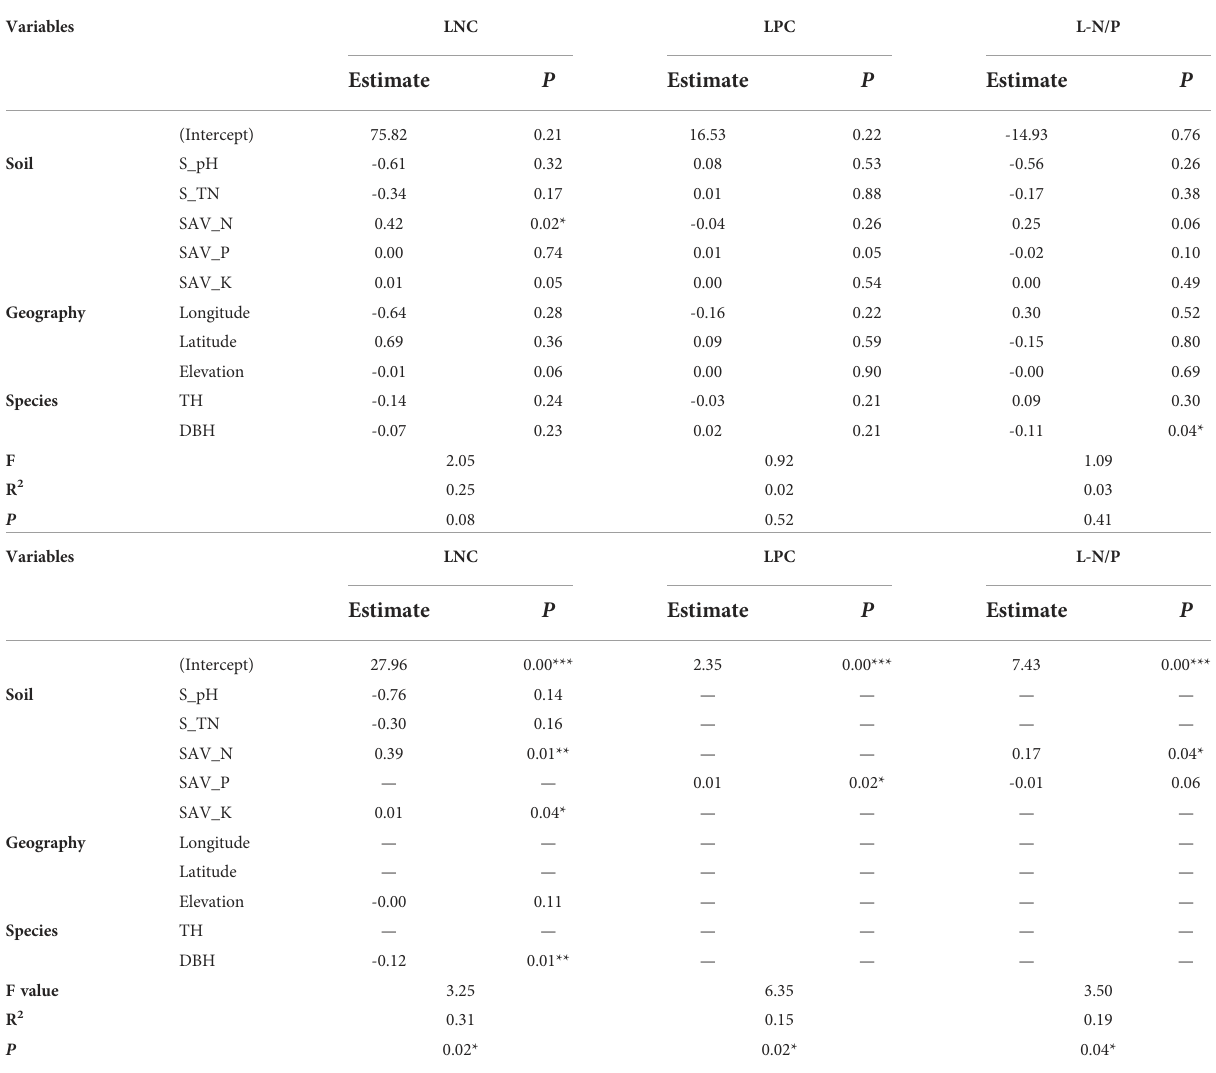
TABLE 1 Multivariate regression analysis of N/P in the foliage of Acer catalpifolium . Variables